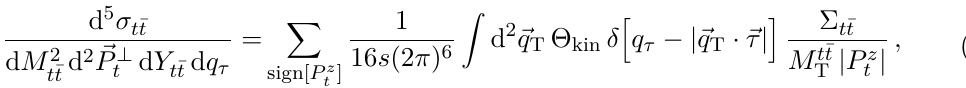
Figure 1 . The kinematics on the transverse plane in the laboratory reference frame. ~P ⊥ for the transverse momentum of the (anti-)top quark. ∆Φ the top and anti-top quarks. ~τ is a unit reference vector in the transverse